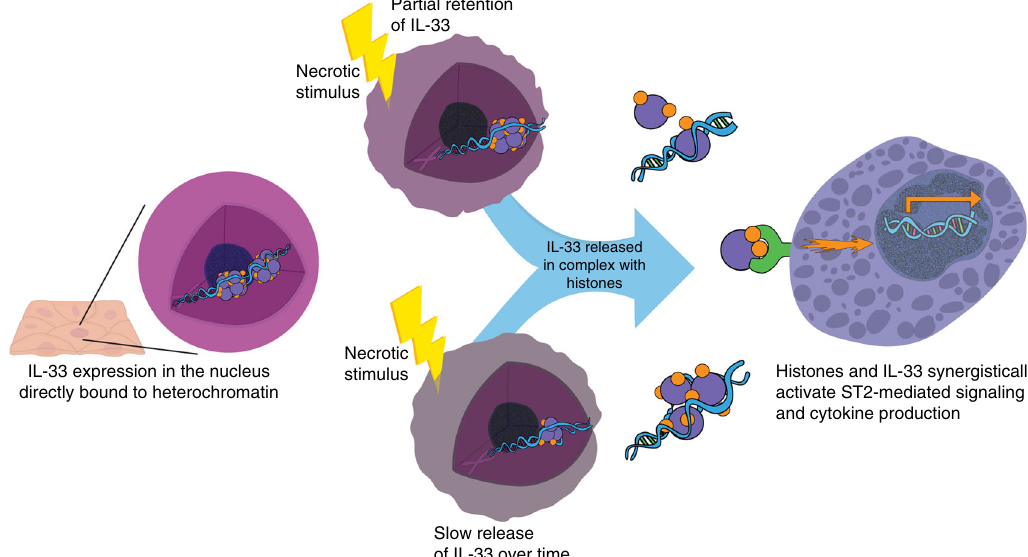
Fig. 9 Model of regulation of IL-33 cytokine activity by chromatin. In live cells, IL-33 remains within the nuclei of epithelial cells due to IL-33 binding to histones. In response to necrotic stimuli, the integrity of the plasma and nuclear membranes is lost, yielding only partial retention of IL-33. Over time, there is slow release of IL-33 from the necrotic cells, either as a monomer or in complexes with chromatin. Released IL-33 and histones then synergize to induce ST2 signaling and downstream gene expression from ST2-expressing cells. IL, interleukin; ST2, suppressor of tumorigenicity